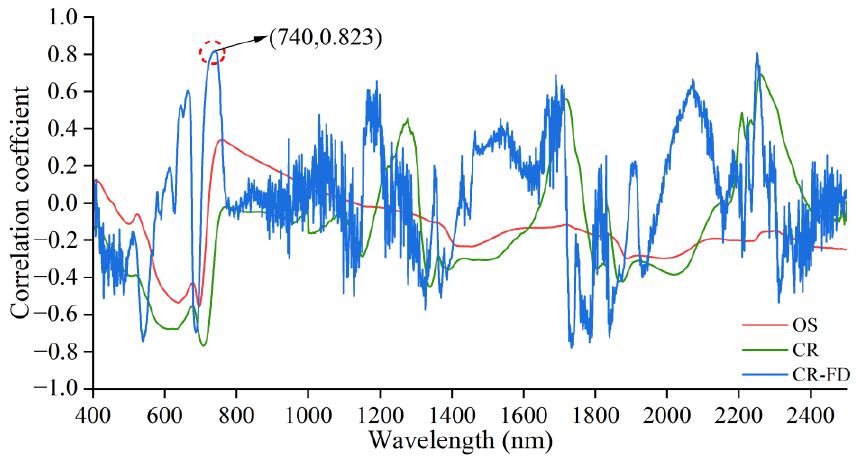
Figure 6. Correlation analysis of spectral data for whole leaf samples with nitrogen content. The number is the area with high correlation, and the scope of the area is predominantly determined according to whether the correlation trend has significantly changed. Original spectrum (OS); continuum removal (CR); continuum removal-first derivative (CR-FD).